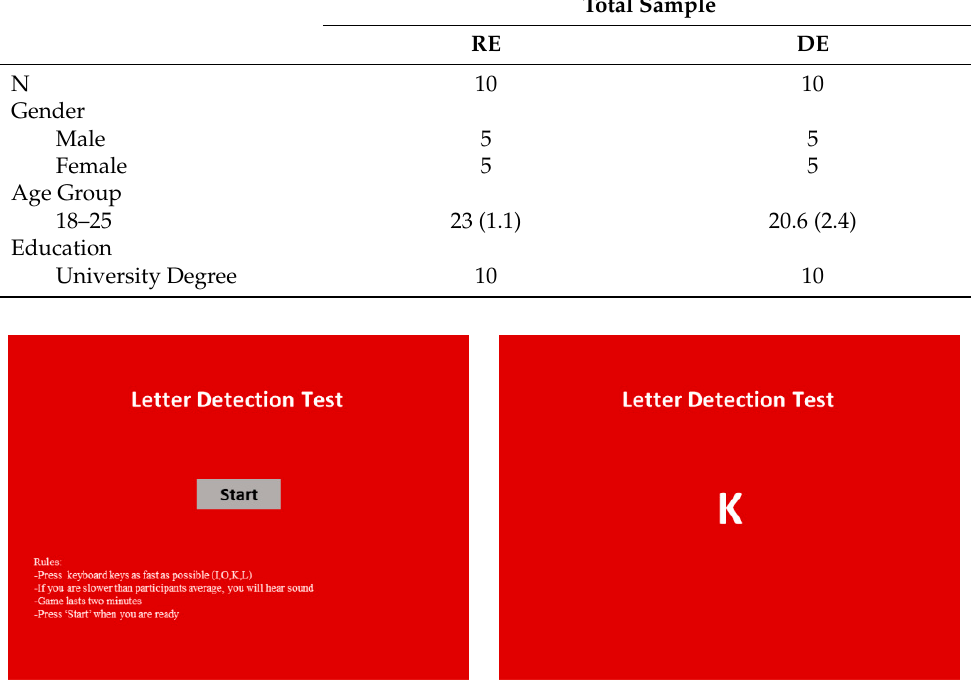
Figure 1. Letter-detection test.